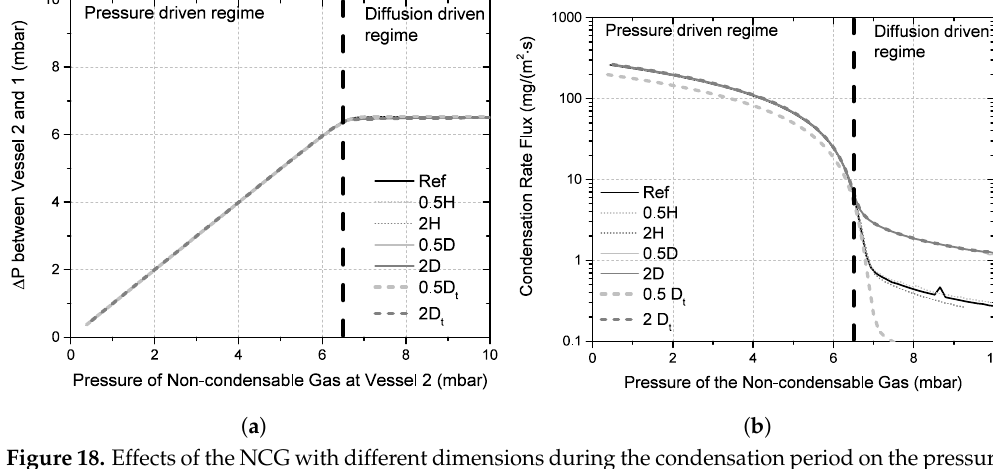
Figure 18. Effects of the NCG with different dimensions during the condensation period on the pressure difference ( a ) and the condenation rate flux ( b ). H: the height of the vessel, D: thickness of the vessel and D t : thickness of the tubing between both vessels.